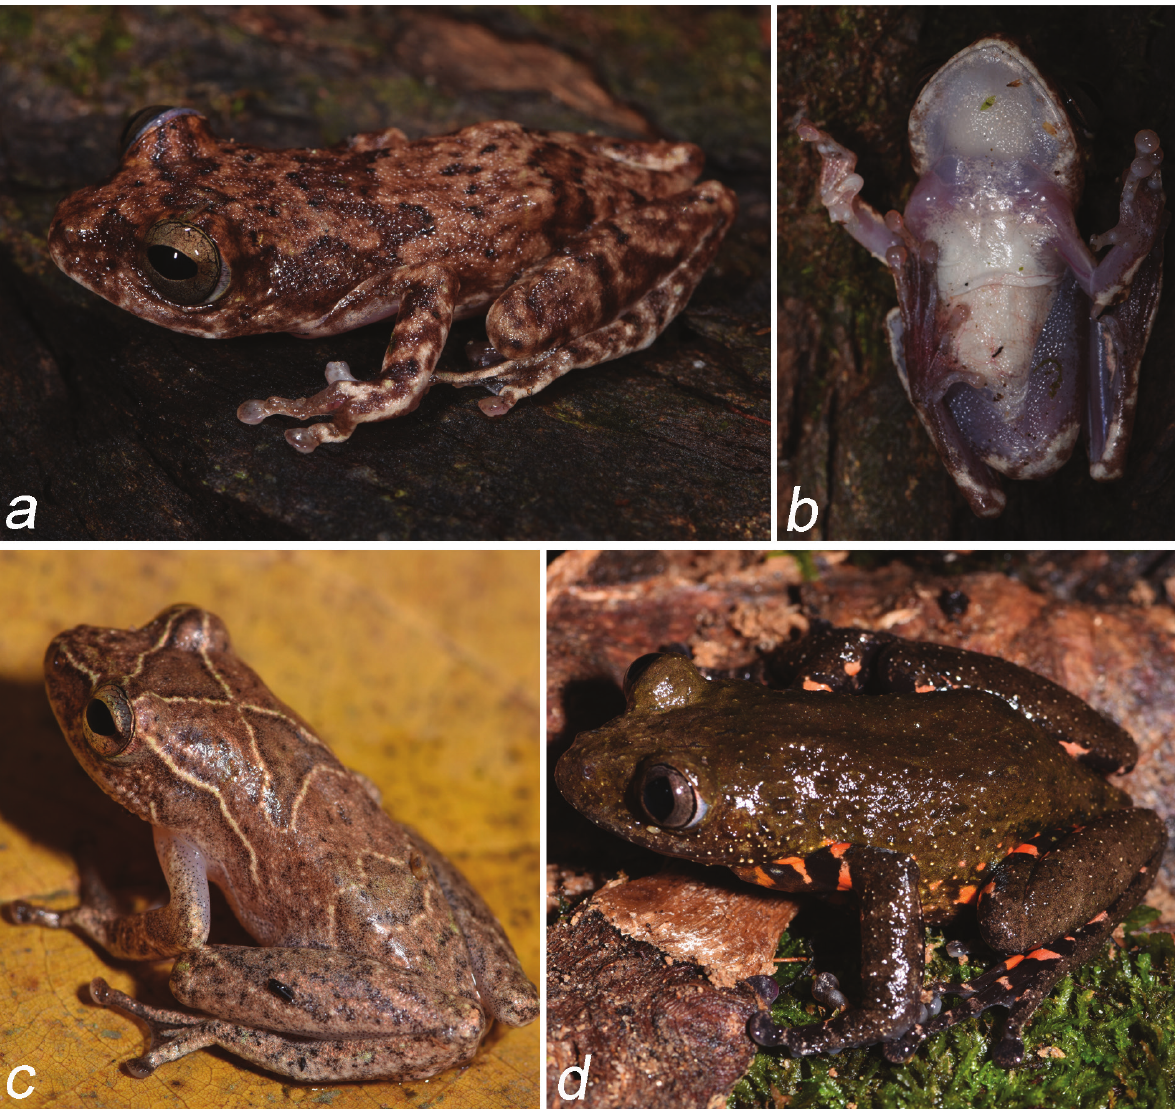
Figure 4. a, b Dorsal and ventral view of male Hyperolius zonatus (ZMB 88446) from KBPPA, showing the white gular region with the roundish gland, lacking dilatable skin of a larger vocal sac c H. concolor (ZMB 88542) with juvenile pattern from FPPA d male Phlyctimantis boulengeri (ZMB 88514) from